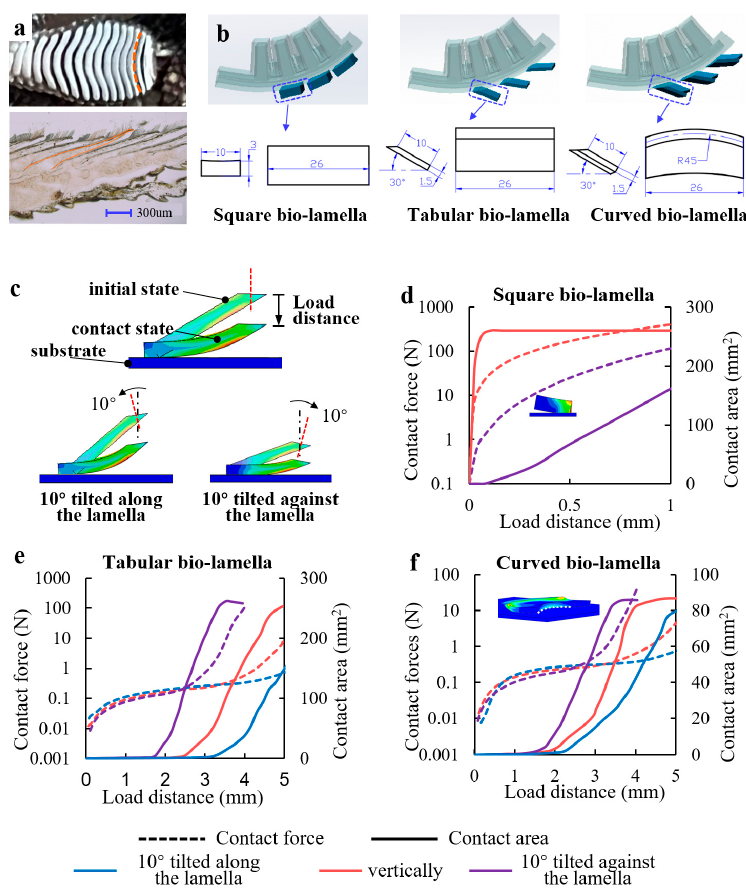
Figure 3. ( a ) Longitudinal frozen slicing and bottom view of the gecko toe’s lamellae. ( b ) Three gecko-inspired bio-lamellae: square, tabular, and curved bio-lamella. ( c ) Finite element models of the tabular bio-lamella’s behavior and mechanical characteristics when contacting a flat substrate under three contact modes (vertically, 10° tilted along the lamella, and 10° tilted against the lamella). Simulation results of contact force and contact area versus load distance for the ( d ) square, ( e ) tabular, and ( f ) curved bio-lamellae.